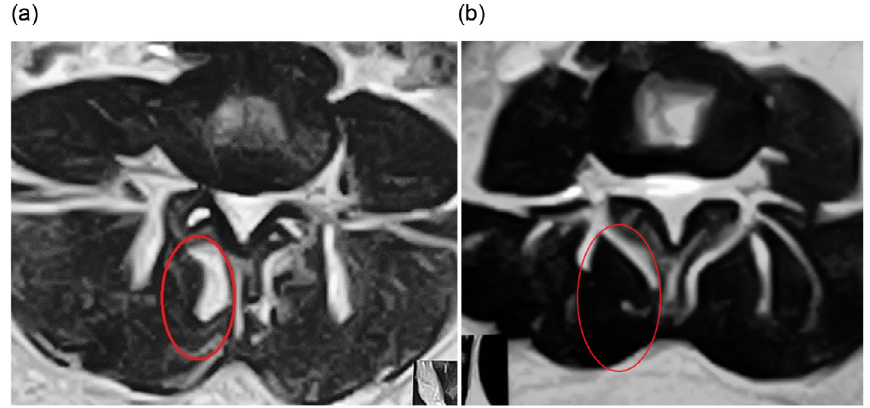
Figure 3. (a) Axial view of lumbar spine MRI shows severe multifidus atrophy, fatty degeneration (high signal intensity) is nearly 50% (red circle), (b) axial view of the same patient after one year post-injection of PLRP into atrophied lumbar multifidus with decreased fatty degeneration.